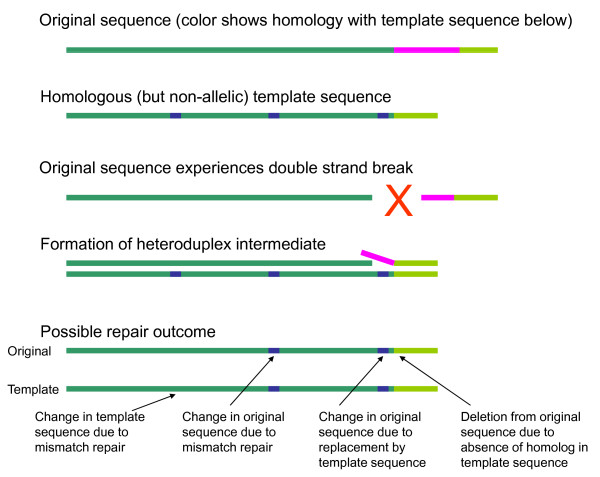
A model of gene conversion between duplicons. Two homologous but non-allelic sequences are shown, with homology indicated by a common green color. After a double strand break in the original sequence, the template sequence is used to form a heteroduplex DNA structure with the original sequence during the process of repair. A possible repair outcome is shown, illustrating changes to both the template and original sequences far from the location of the break, as well as changes and deletion in the original sequence in the vicinity of the break.